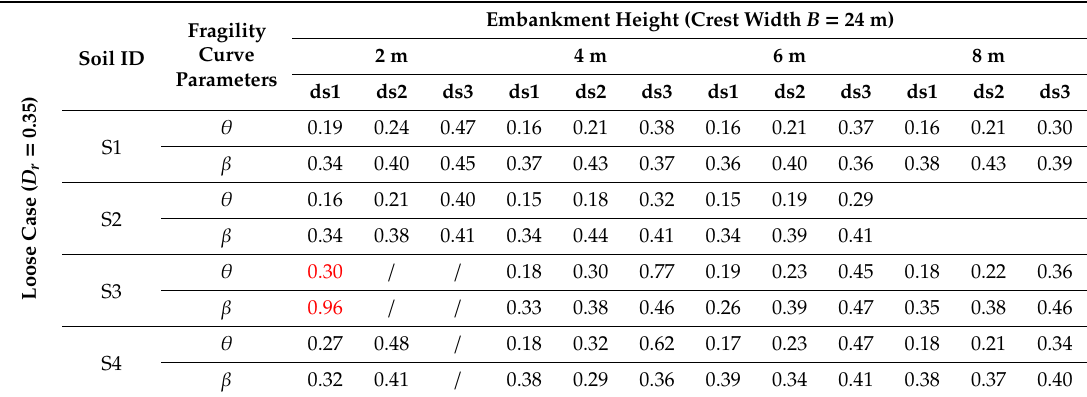
Table 9. FC parameters for di ff erent embankment heights (loose soil, PGA, railway criteria).